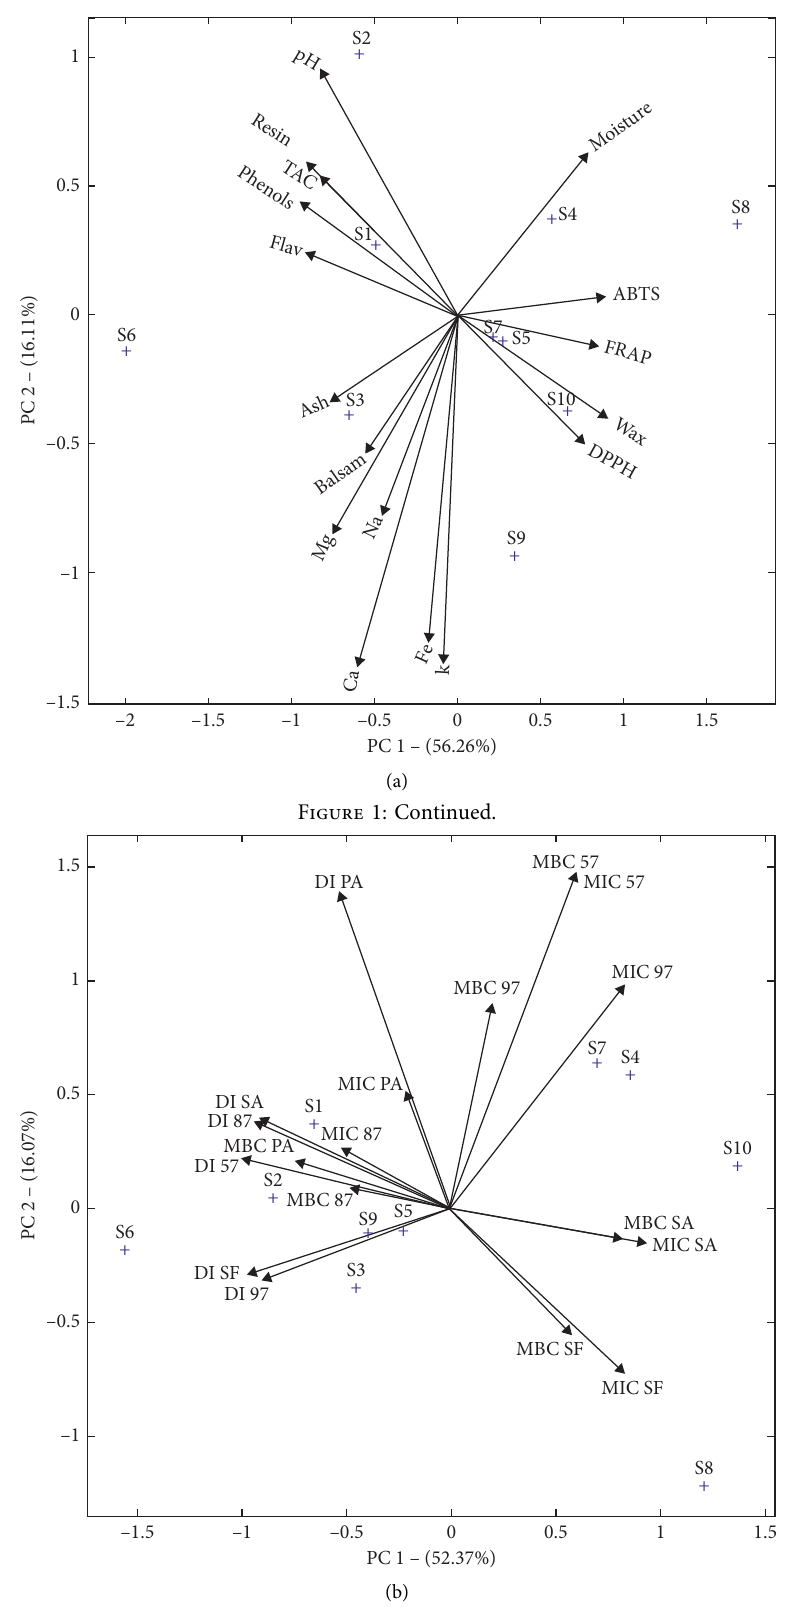
Figure 1: Principal component analysis of the assessed parameters. (a) PCA of the physicochemical parameters and the antioxidant activities. (b) PCA of the antibacterial activity. pH; resin; wax; ash; moisture; phenols, total phenolic; Flav, flavone and flavonol content; TAC, total antioxidant capacity; DPPH; ABTS; FRAP; K, potassium; Na, sodium; Ca, calcium; Mg, magnesium; Fe, iron; DI, diameter of inhibition zone; MIC, minimum inhibitory concentration; 57, E.coli (ATB: 57) B6N; 87, E.coli BLSE (ATB:87) BGN; 97, E.coli (ATB: 97) BGM; PA, Pseudomonas aeruginosa ; SA, Staphylococcus aureus ; SF, Streptococcus faecalis